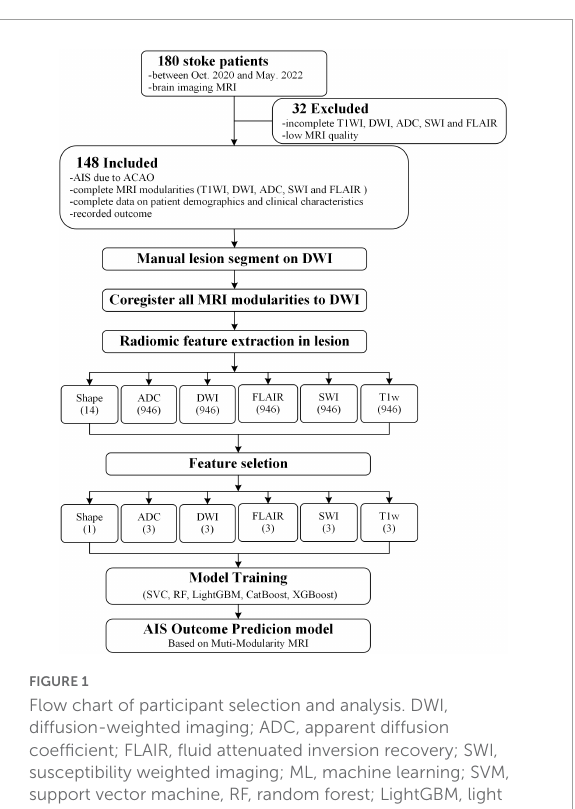
FIGURE1 Flow chart of participant selection and analysis. DWI, diffusion-weighted imaging; ADC, apparent diffusion coefficient; FLAIR, fluid attenuated inversion recovery; SWI, susceptibility weighted imaging; ML, machine learning; SVM, support vector machine, RF, random forest; LightGBM, light gradient boosting; CatBoost, category boosting, and XGBoost, eXtreme gradient